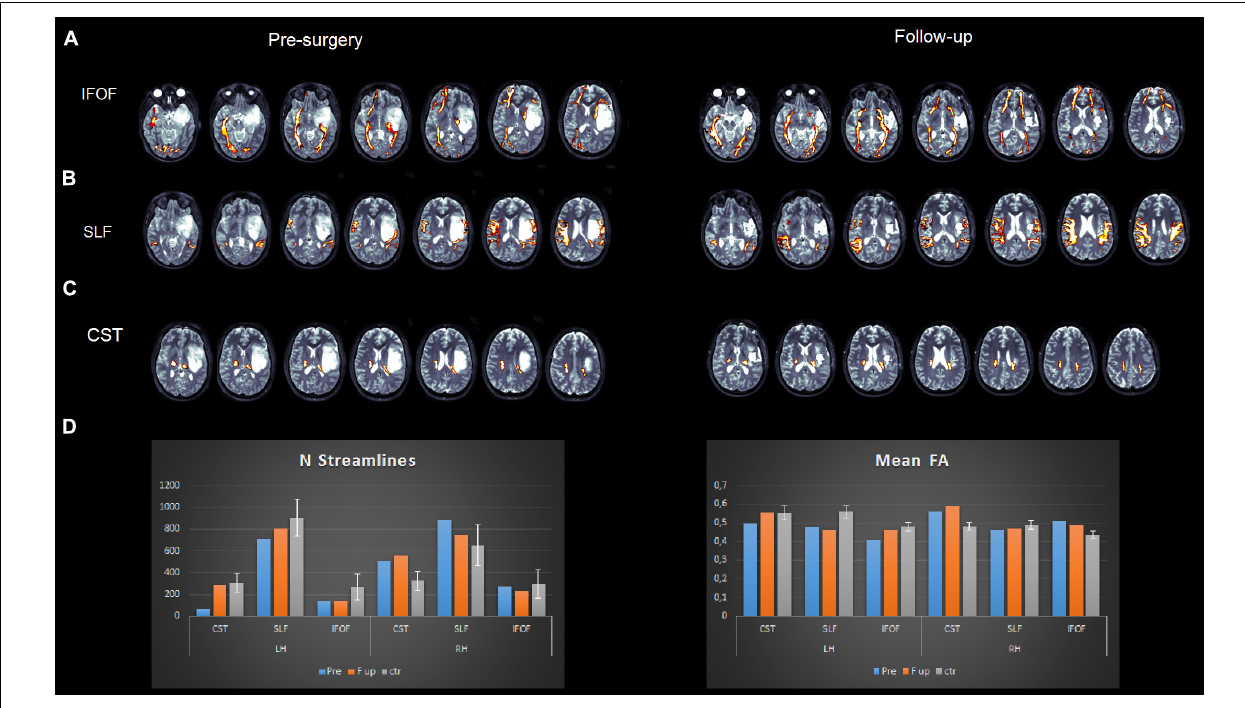
FIGURE 3 | Pre- (left panel) and post (right panel)-surgery fMRI maps for tongue movements (A) , object naming (B) , verb naming (C) , and word/pseudoword reading (D) tasks. Activations are superimposed on the T2-weighted MRI axial slices of the